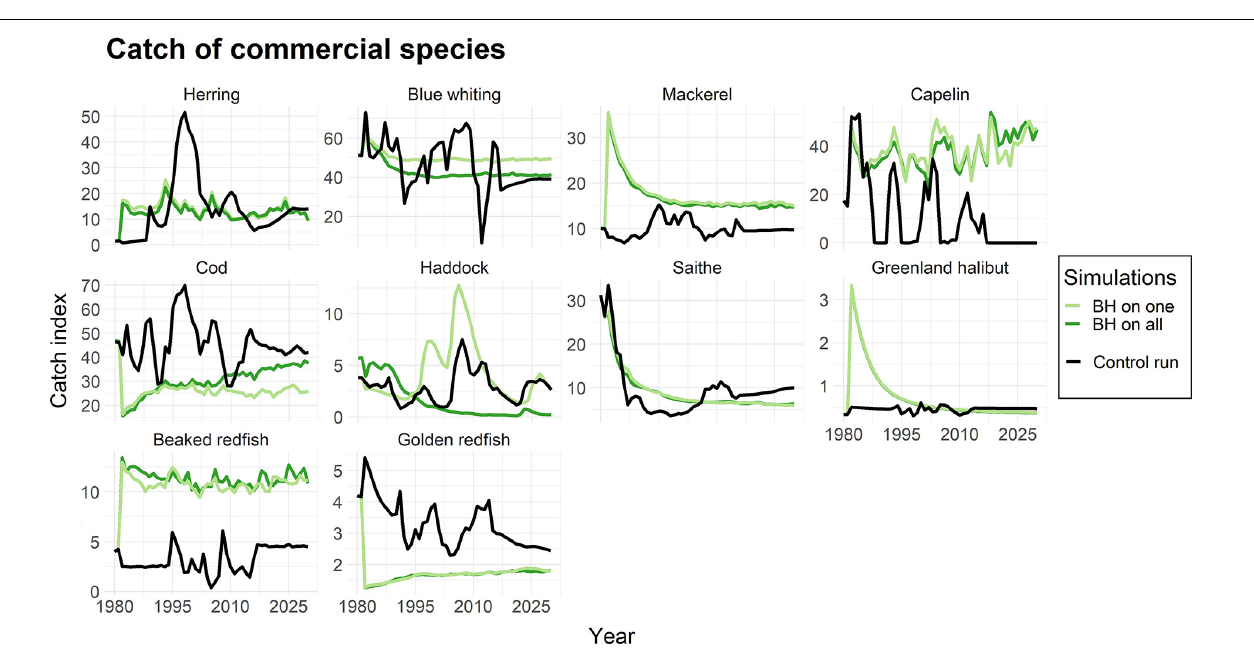
FIGURE 4 | Change in biomass compared to control run for non-commercial species. The light purple line represents simulations were only that species were subjected to a BH regime, while the dark purple line shows the biomass when all species in the study were subjected to BH. The black line represents the control run where a traditional fishing regime was applied to the commercial species and the non-commercial species were not harvested. The biomass is given as an index.